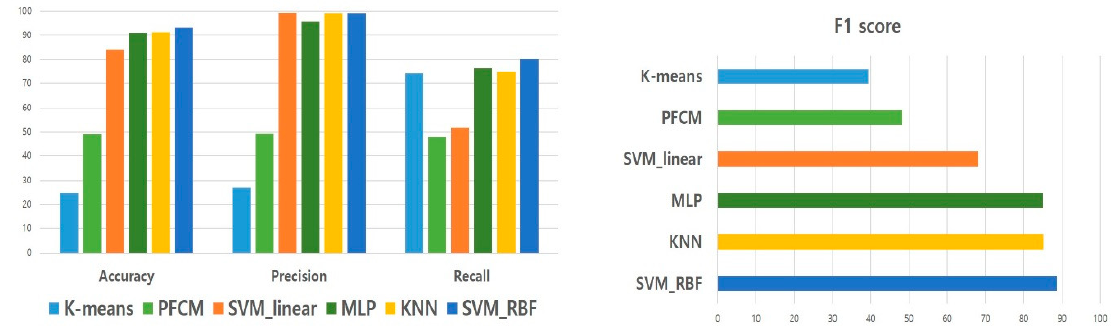
Figure 13. Summary of performance comparison of cigarette detection algorithm.